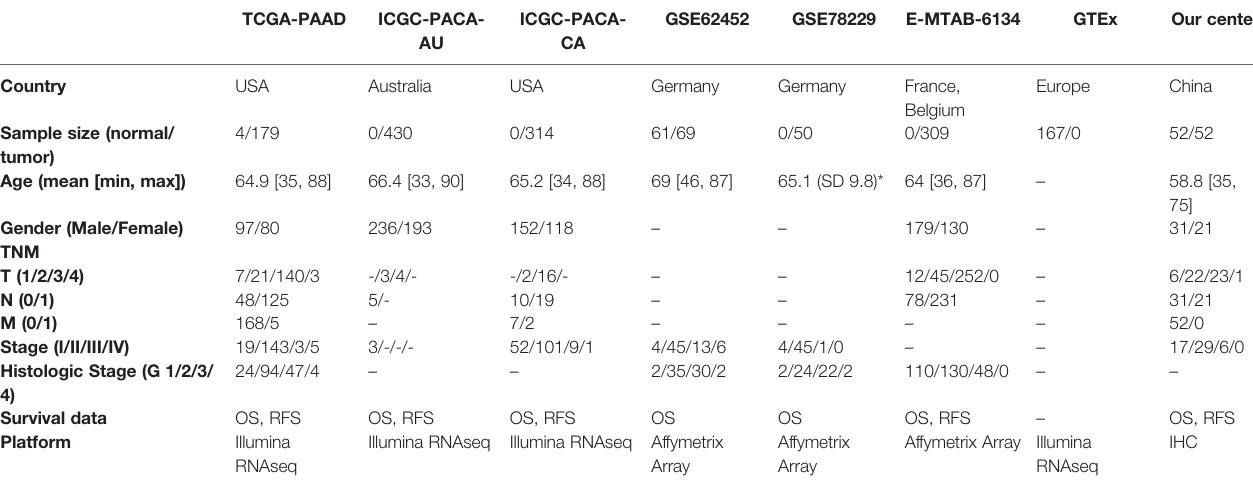
TABLE 2 | Datasets included in this